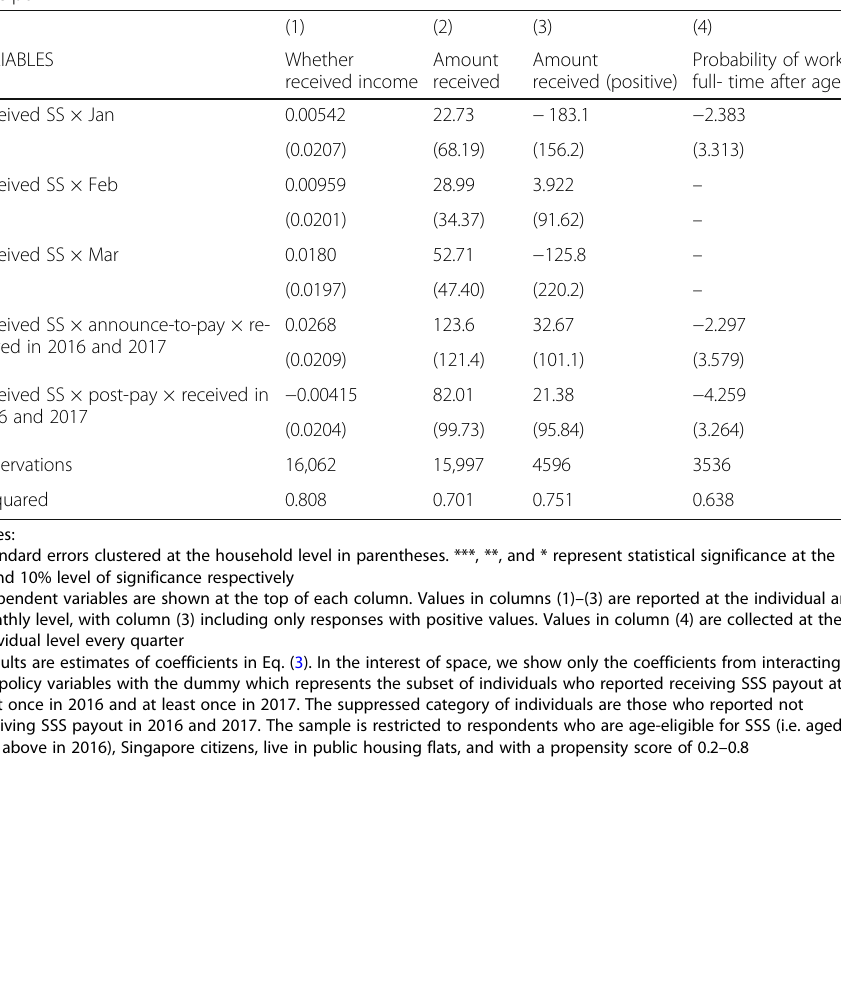
Table 8 Robustness check for labour decisions — accounting for misreporting of SSS